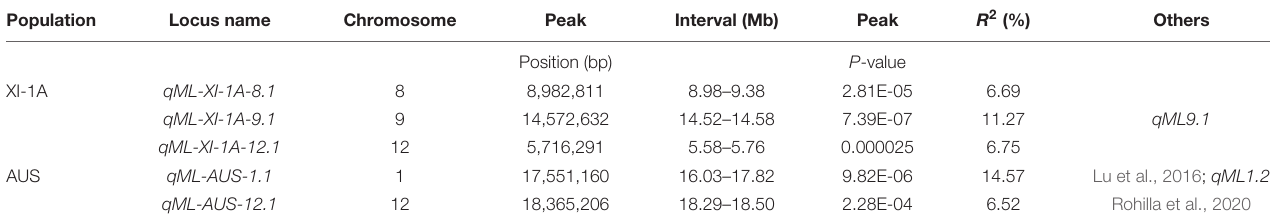
FIGURE 6 | Genome-wide association study (GWAS) for mesocotyl length in the XI-1A and AUS panels. TABLE 3 | GWAS for mesocotyl length in the XI-1A and AUS